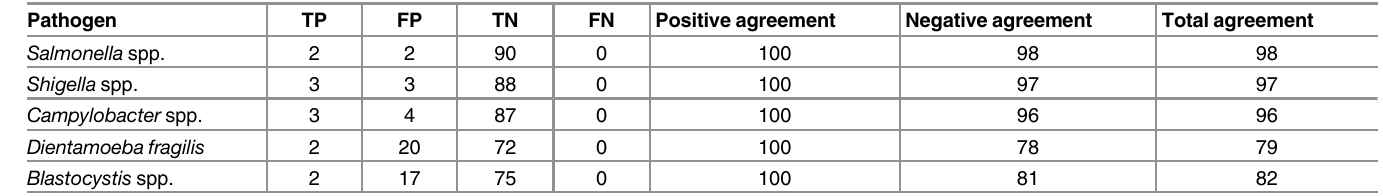
Blastocystis spp.